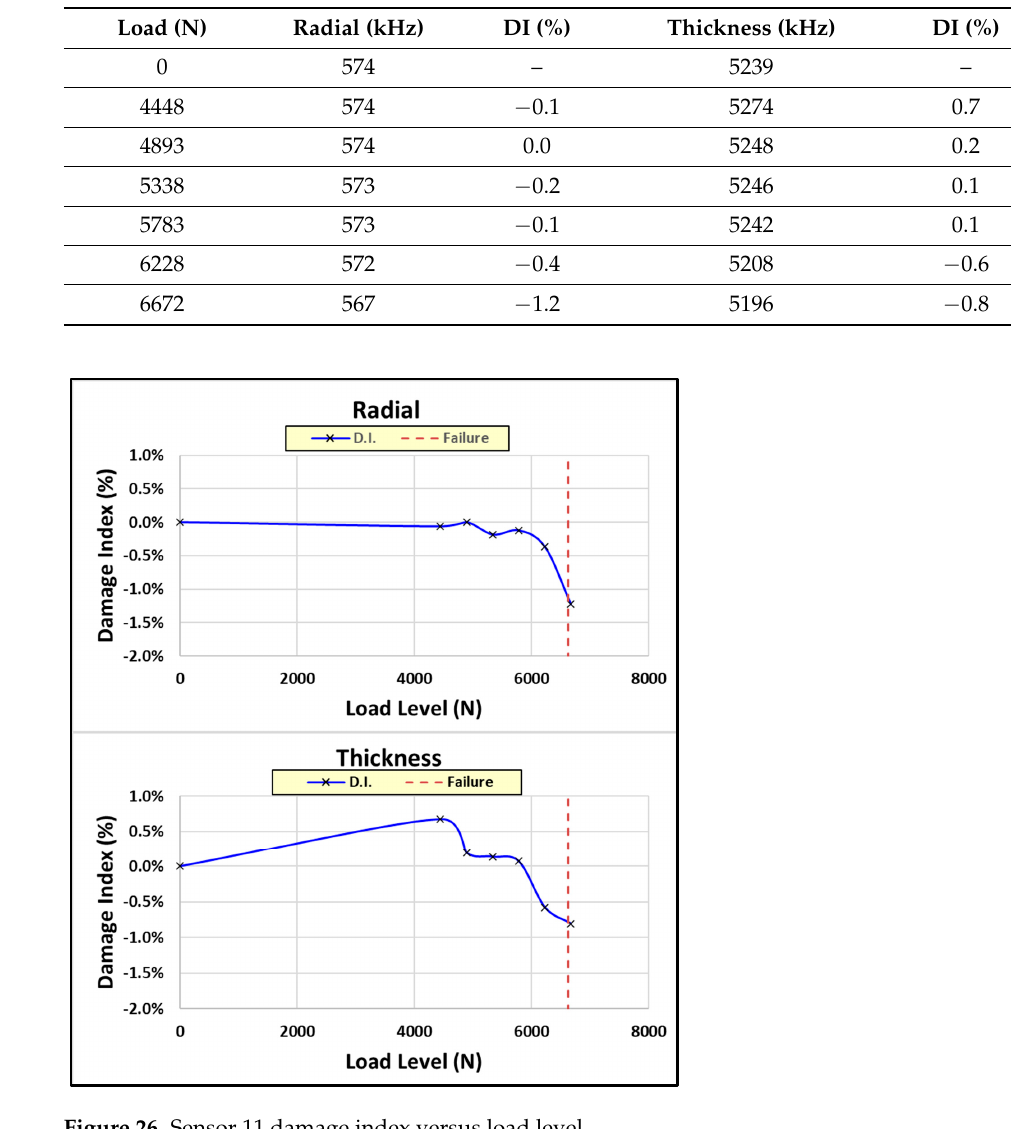
Table 5. Load and damage index (DI) sensor #11.